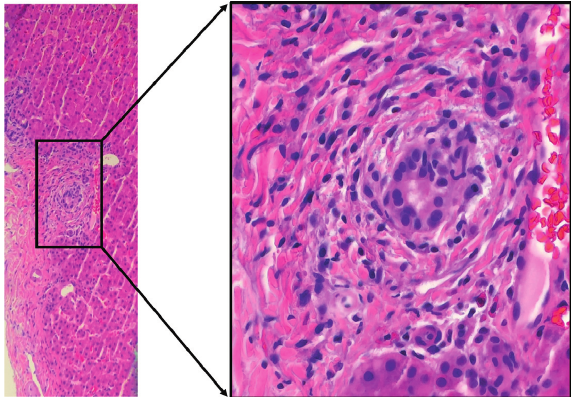
Figure 1: Representative stained image of biopsied liver. Char- acteristic onion skinning with focus of bile duct injury suggestive of ductular reaction to insult. Marked infiltration of neutrophils evident. Magnified image of boxed area is shown as image on the right. Blue staining indicates